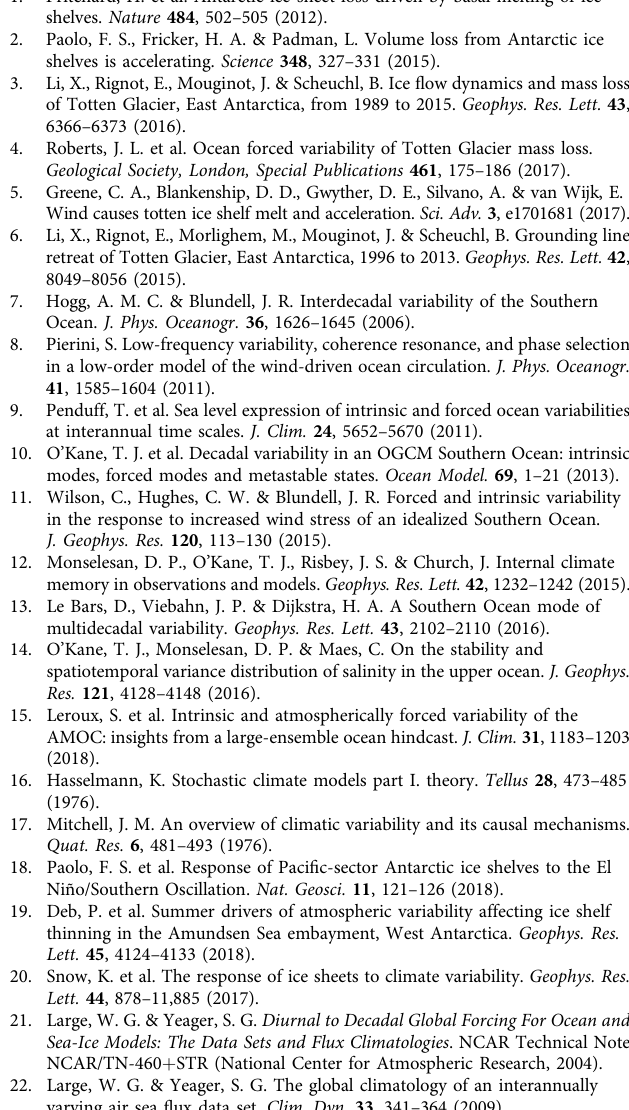
Figs. 3j – m and 4g – j. Plots made with assistance from the Antarctic Mapping Tools for MATLAB toolbox 44 and cmocean 45